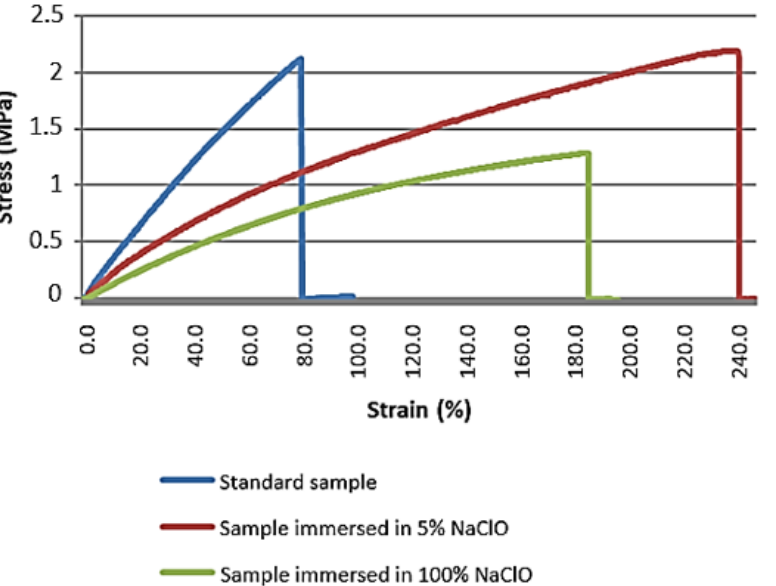
Figure 17. Stress-strain graph of the oak tensile test for the standard sample and samples immersed for three weeks in 5% and 100% NaClO